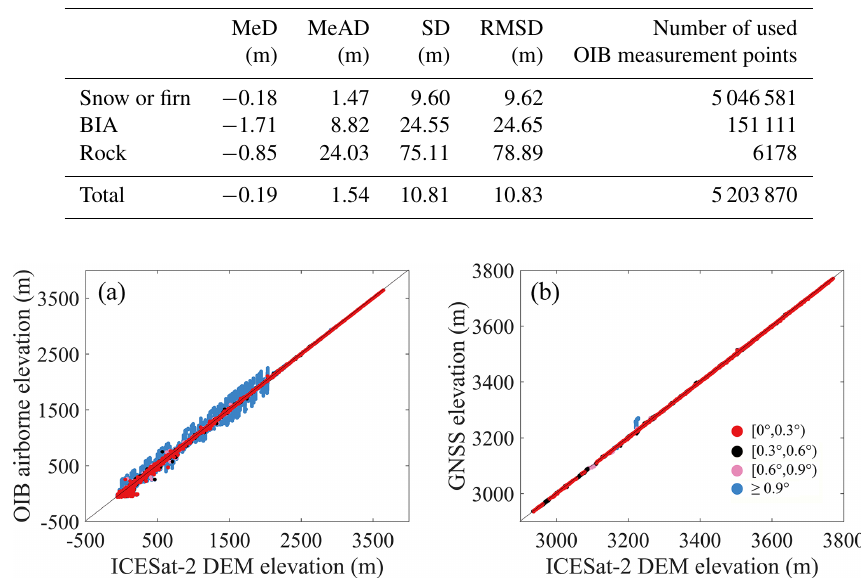
Table 5. Comparison between the ICESat-2 DEM and OIB airborne elevation measurements (including data in areas of low elevation change from 2009 to 2017 and data in the Antarctica from 2018 to 2019) with respect to three surface types, i.e. snow or firn, blue ice areas (BIAs) and rocks. The surface type data are obtained from Hui et al. (2017).